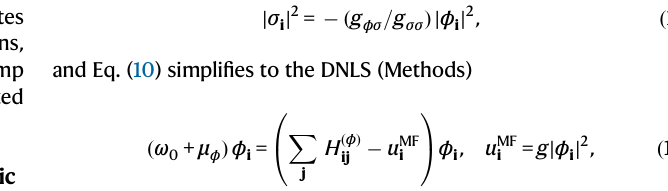
solvingthefullDNLSinEq.(3).Wethenperformasimilarcomparisonin